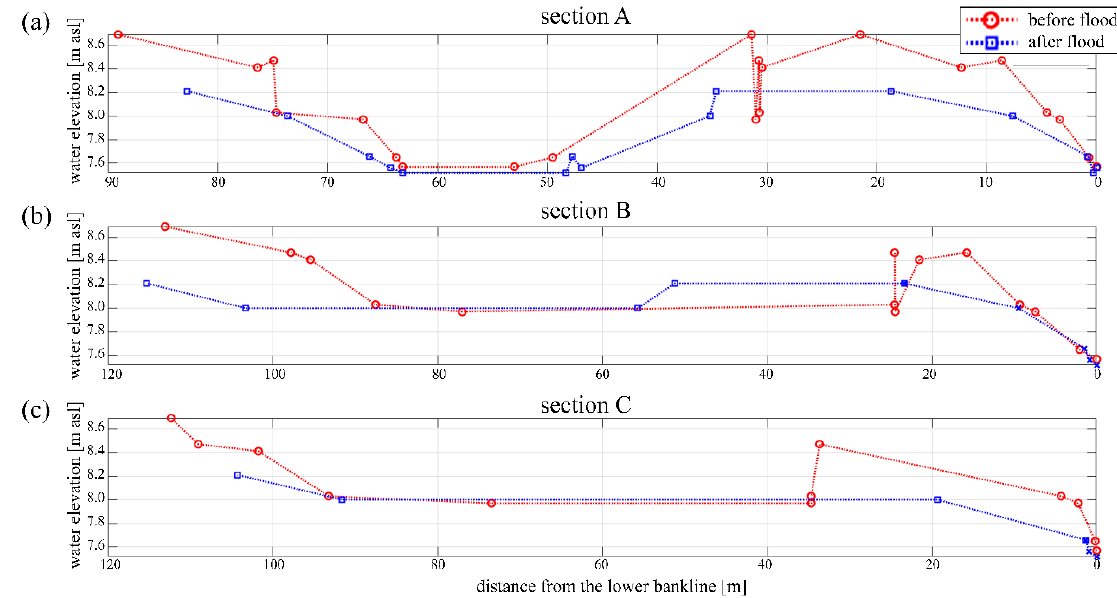
Figure 8. Comparison between riverine morphologies before (red line) and after (blue line) the flooding event in ( a ) section A, ( b ) section B and ( c ) section C, as resulted from the edge-of-water lines time-lapse photography. The x -axis represents the distance from the lower edge-of-water line while the y -axis indicates the water elevation measured at the gauging station of Revere corrected by accounting for the mean slope of the free surface.